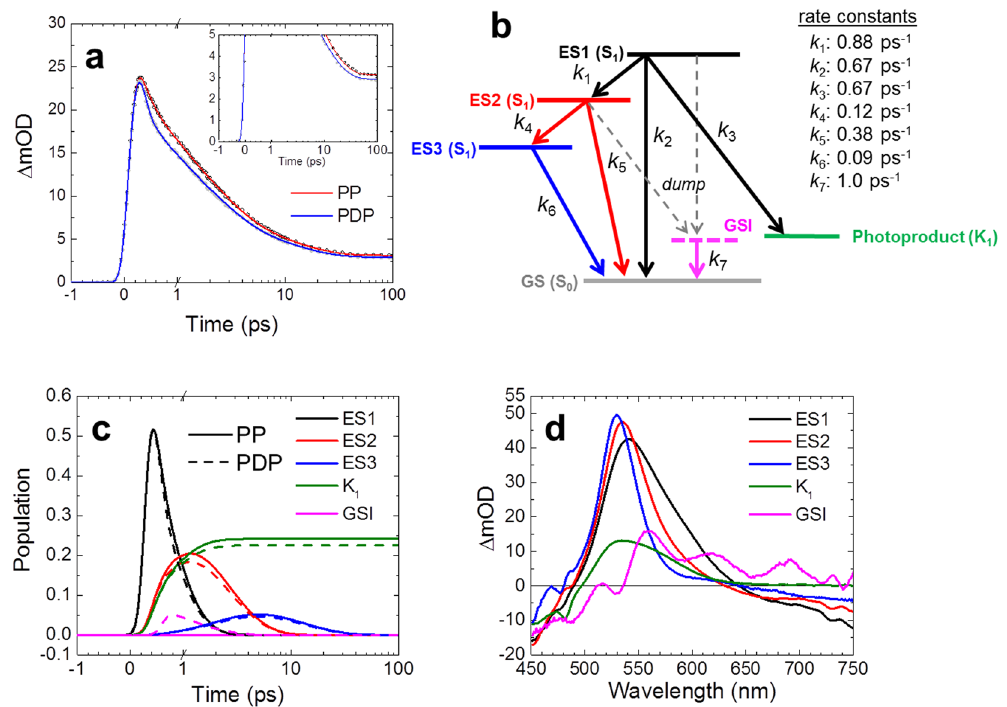
Figure 3. Pump-dump-probe data of C1C2 at pH 8 and target analysis results. ( a ), Time traces of pump probe (PP, open black dots with a red fitting line) and pump-dump-probe (PDP, closed gray dots with a blue fitting line) at 530 nm. In a and c, the time axis is linear until 1 ps, and logarithmic thereafter. ( b ), Kinetic scheme consisting of three excited states (ES1, ES2 and ES3), the first photoproduct state (K 1 ) and ground state intermediate (GSI). The dump pulse at 300 fs converts a fraction of the excited states to the GSI. It affects ES1 and ES2, which is indicated by the dashed gray arrows. ( c ) Time evolution of populations of ES1, ES2, ES3, K 1 and GSI. The solid and dashed lines represent pump-probe (PP) and pump-dump-probe (PDP) data, respectively. ( d ) Species-associated difference spectra (SADS) of pump-dump-probe